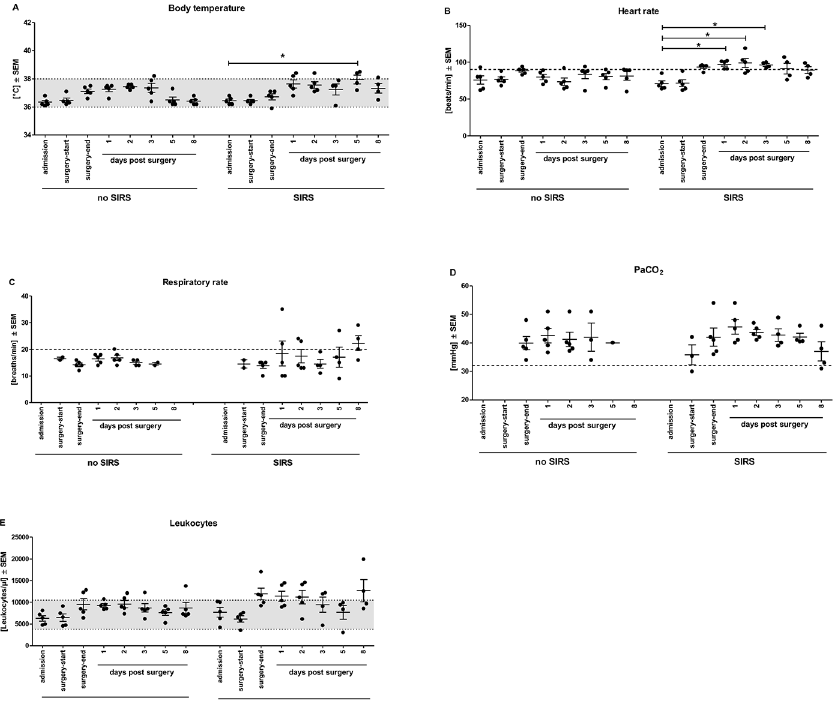
Fig 1. SIRS parameters of selected study patients. (A) Body temperature, (B) heart rate, (C) breathing rate, (D) PaCO 2 and (E) leukocyte counts are presented as means ± SEM per study group. Dotted lines indicate threshold values to pathological levels, shaded areas between dotted lines indicate the physiological ranges. * p < 0.05 Kruskal-Wallis with Dunn ’ s multiple comparison post-hoc test for selected data